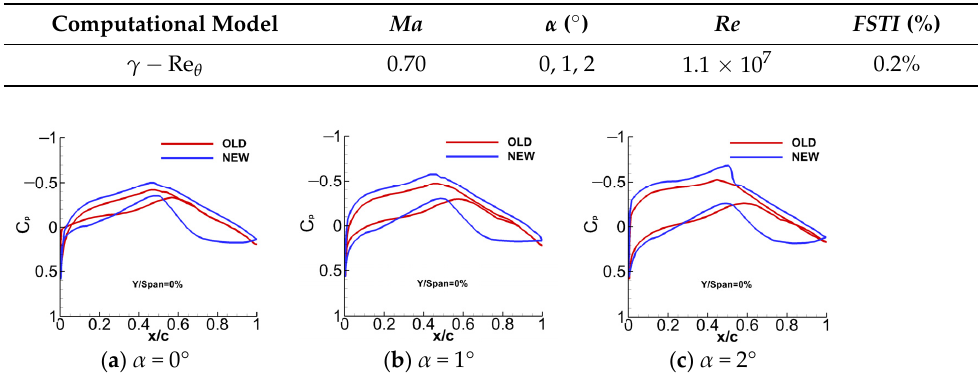
Figure 25. Comparison of C p curves of the central experiment wing.